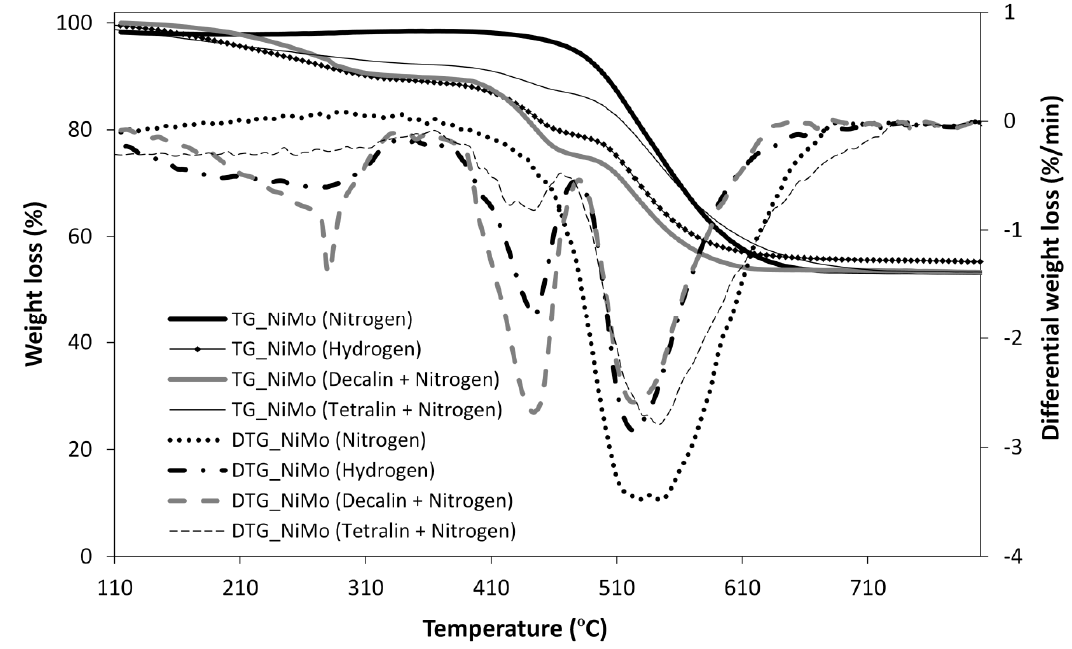
Figure 4. Coke deposited on spent catalyst. Table 1. Upgraded oil asphaltene content, spent catalyst coke and burn-off temperature.